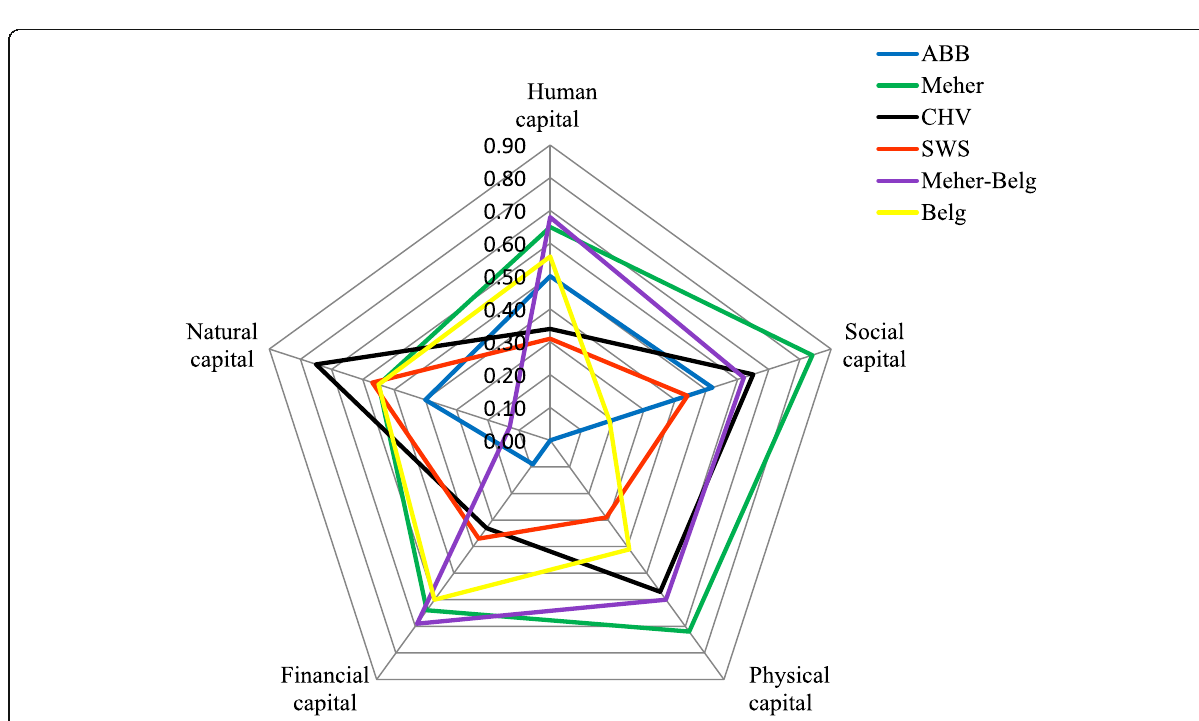
Fig. 10 The level of livelihood capitals for adaptive capacity at each livelihood zones using spider